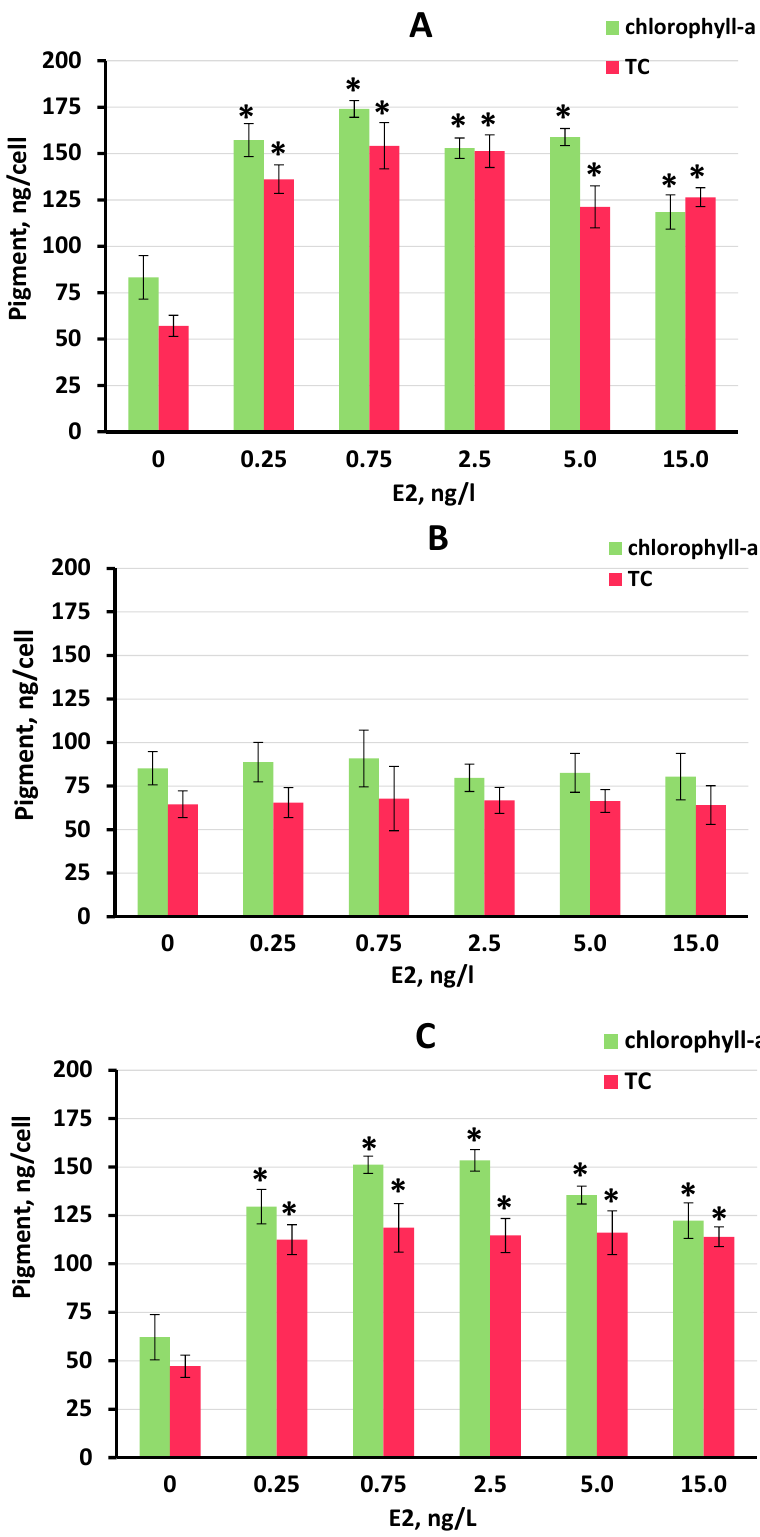
Figure 4. Chlorophyll-a and total carotenoid (TC) content in S. quadricauda cells cultured in the three media containing E2 concentrations of 0.25 ng/L to 15 ng/L on day 11 of the experiment: ( A ) FWW; ( B ) RFWW; and ( C ) BBM. Statistically significant differences from the controls ( p < 0.05) are shown for total cell density, where *—significantly greater than the control. Data are shown as the mean ± SD, n = 6. Control cultures did not contain E2, indicated by “0”.